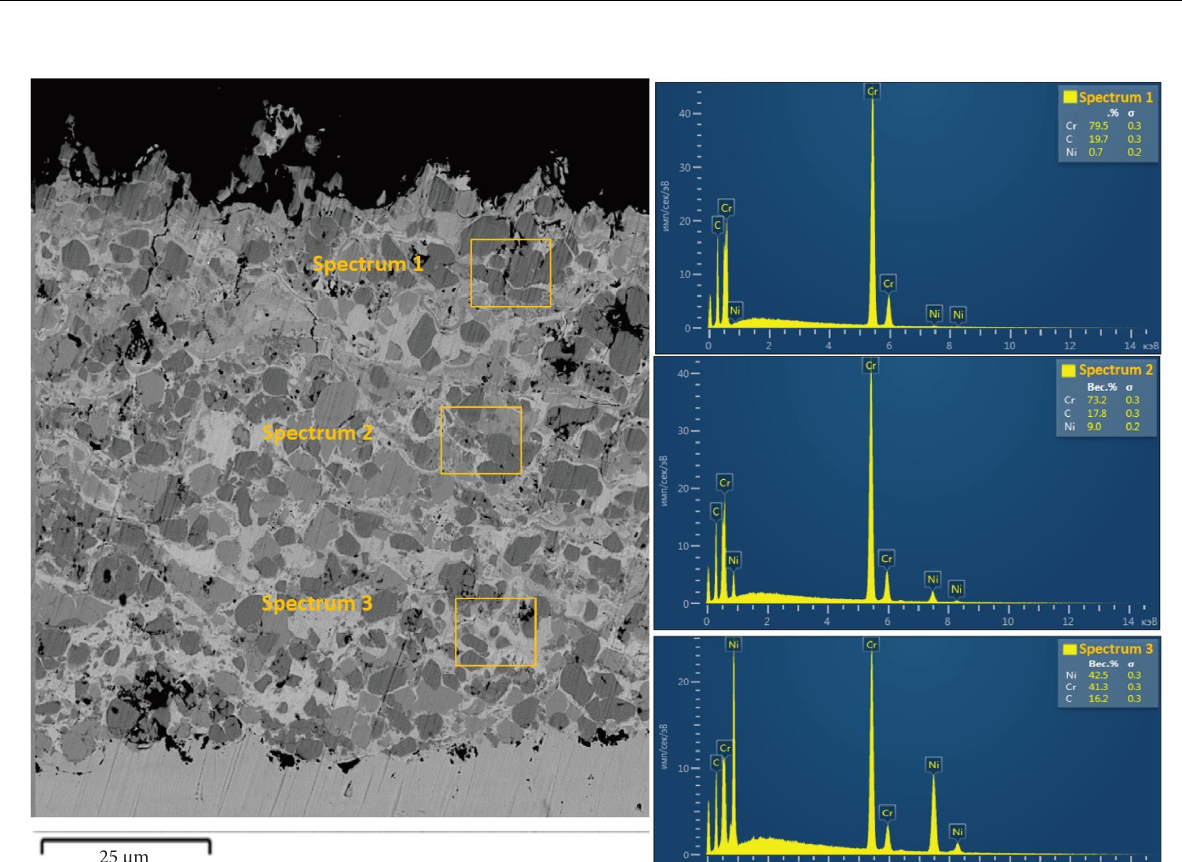
Figure 7: SEM images of Cr 3 C 2 gradient coating and results of EDS analysis performed on three